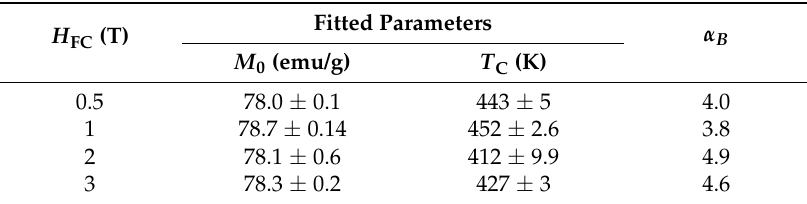
Table 2. The fitting parameters of the experimental data to a modified Bloch’s law in sample S1. H FC (T) Fitted H FC (T)